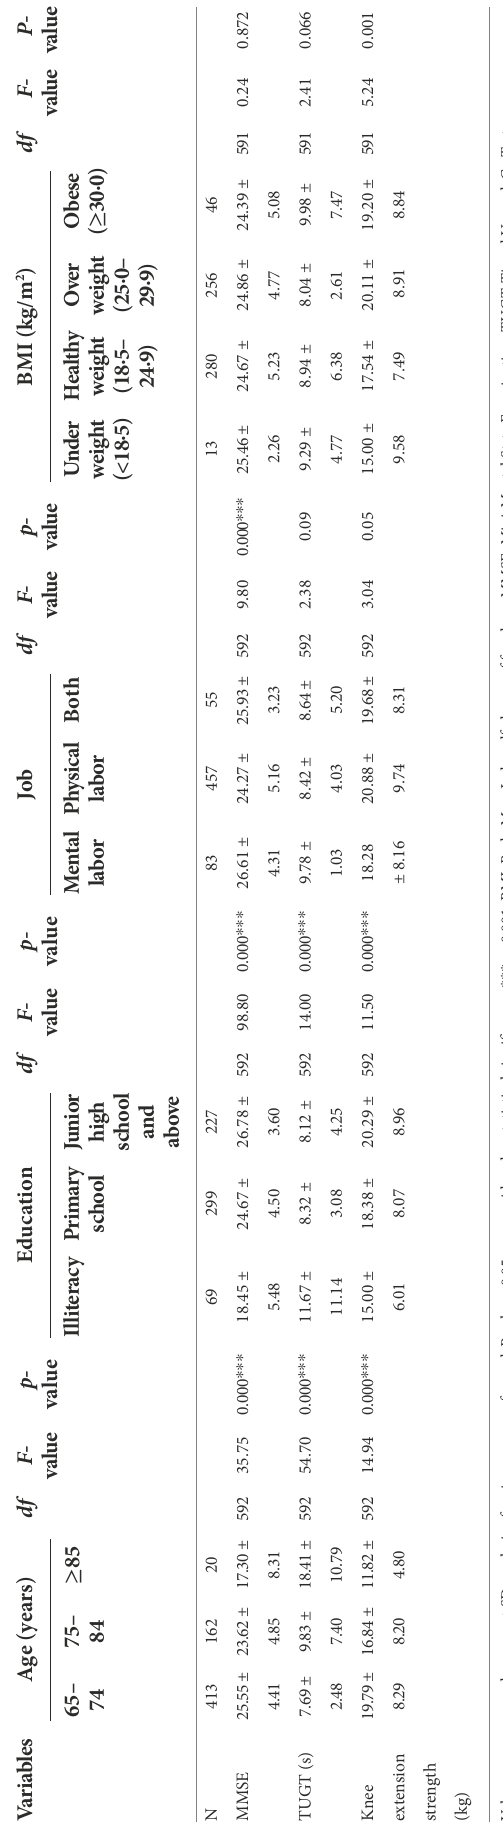
Table 7. In addition, the mediating effect test was conducted using the bootstrap method with 5,000 samples. Results showed that the 95% CI of the mediating effect value of lower extremity